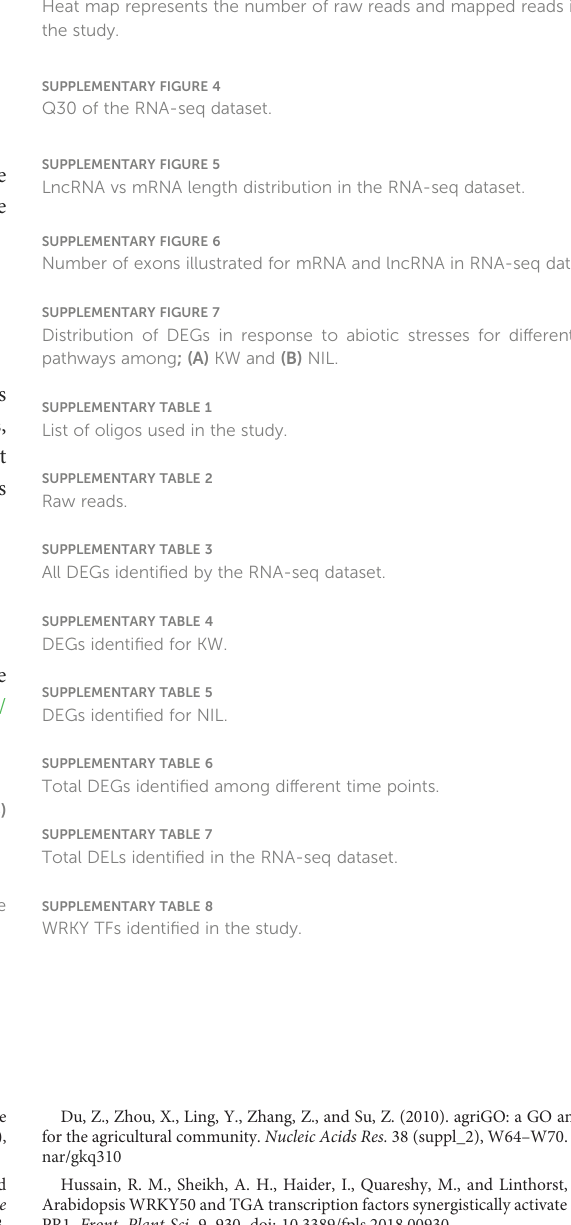
Heat map represents the number of raw reads and mapped reads identi fi ed in the study.